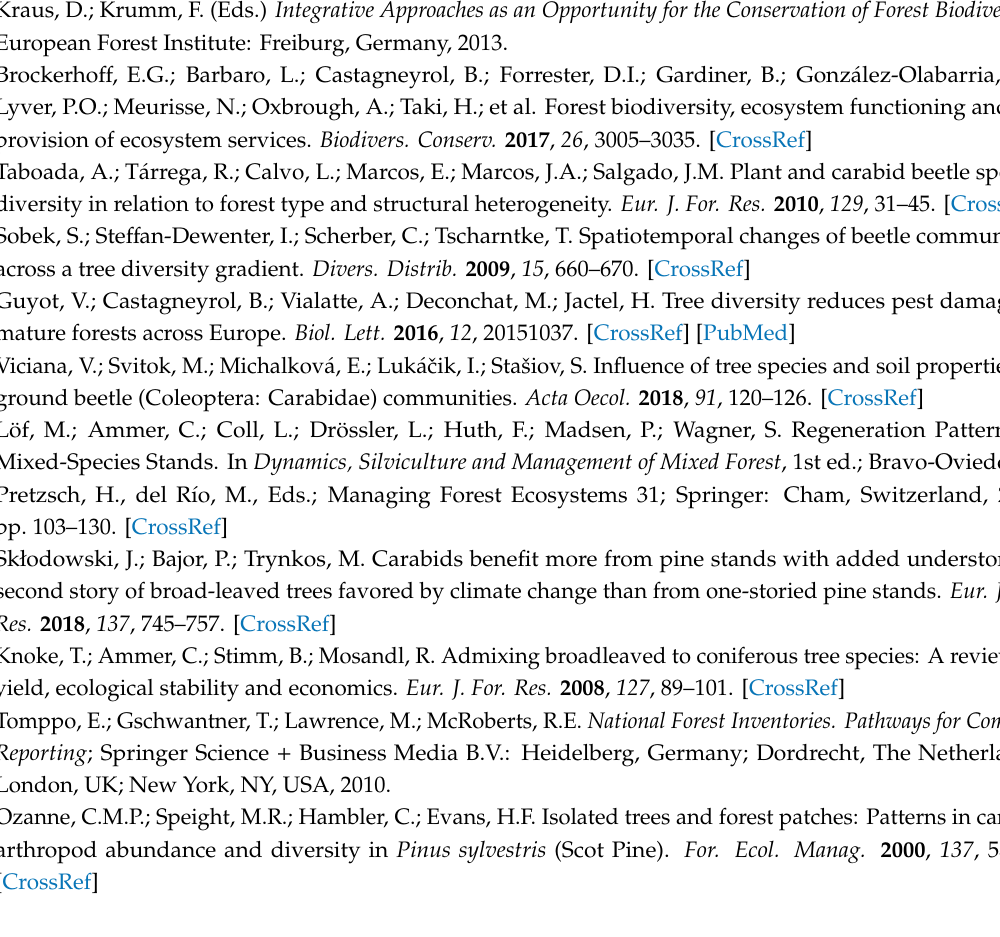
Figure S1: Semi-variograms for testing autocorrelation e ff ects with varying trap distances for intraspecific interactions. The graph of a local polynomial regression is also drawn in. Please note the di ff erent y-scales., Figure S2. Semi-variograms for testing autocorrelation e ff ects with varying trap distances for interspecific interactions. The graph of a local polynomial regression is also drawn